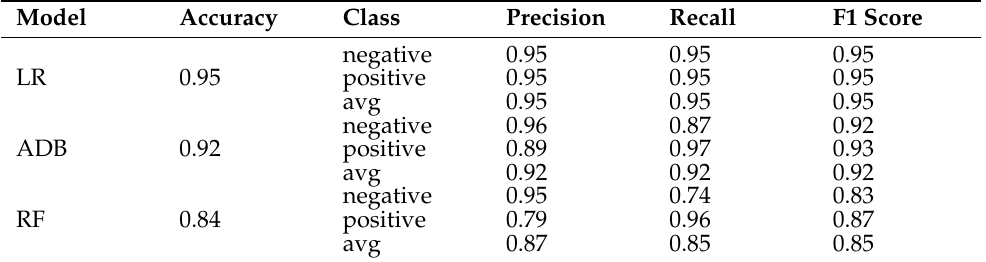
Table 11. Experimental results of ML models with TextBlob sentiments using